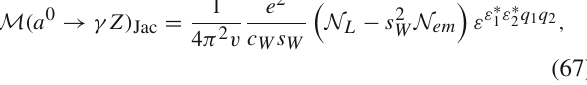
non-linear theory, but the neutrino is absent in the linear one since we take it as massless. For W + W − , it is understood that in between the two W s, the SU ( 2 ) L partner of the indicated fermion propagates